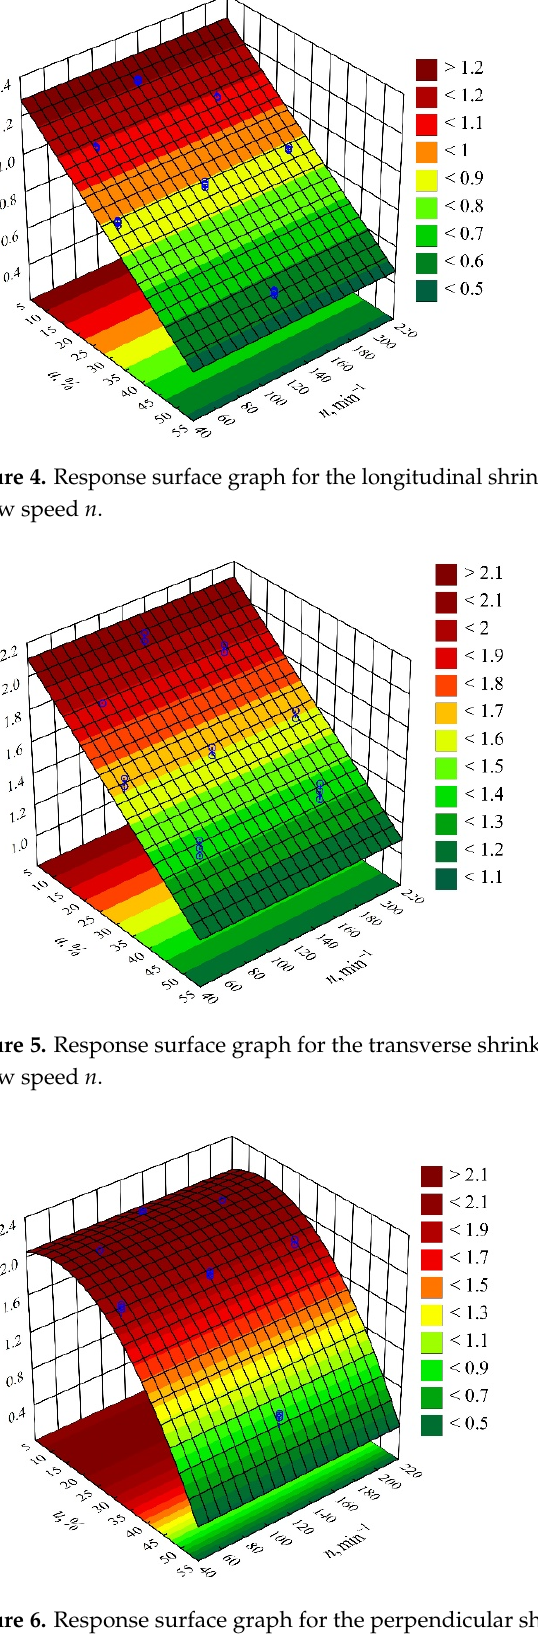
Figure 6. Response surface graph for the perpendicular shrinkage S P versus wheat bran content u and screw speed n.